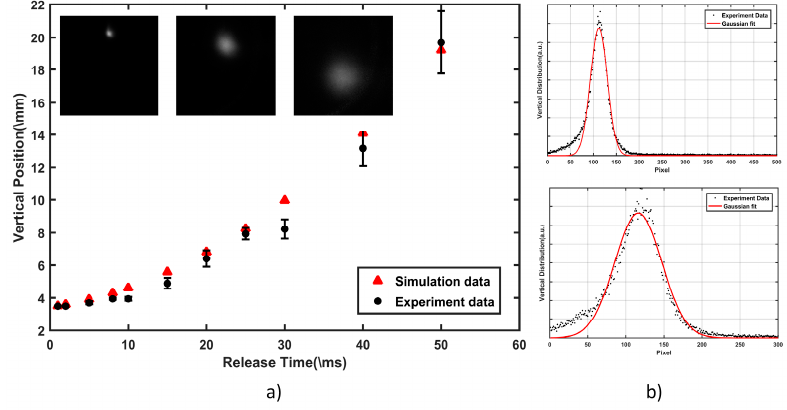
Figure 2. ( a ) Vertical position of free-fall atoms at varied release times. The insets are fluorescence images of the atom cloud in the detecting chamber, captured at 2, 10, and 40 ms after MOT2 is switched off. ( b ) Vertical distribution of released atom cloud at 2 and 5 ms after MOT2 is switched off. The red lines show the Gaussian fit of the experimental